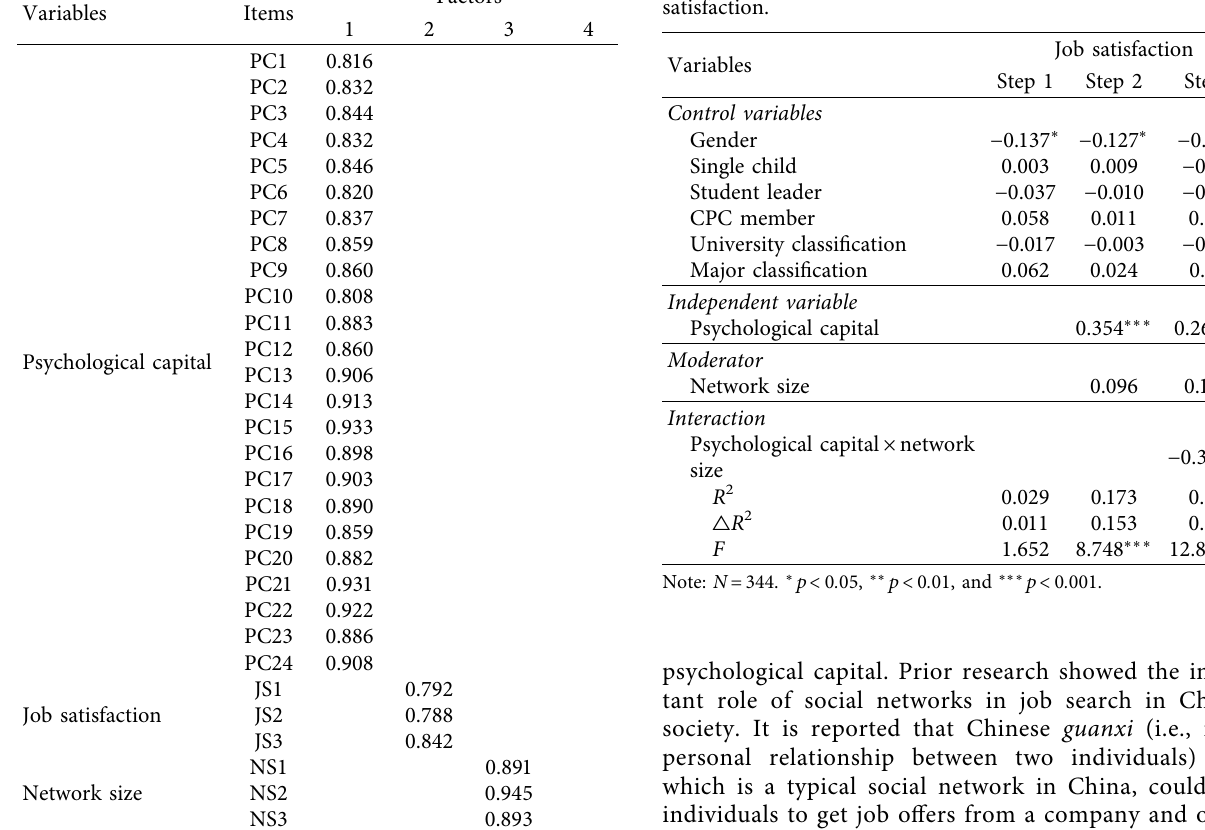
Table 5: Results of exploratory factor analysis (EFA) in the study.